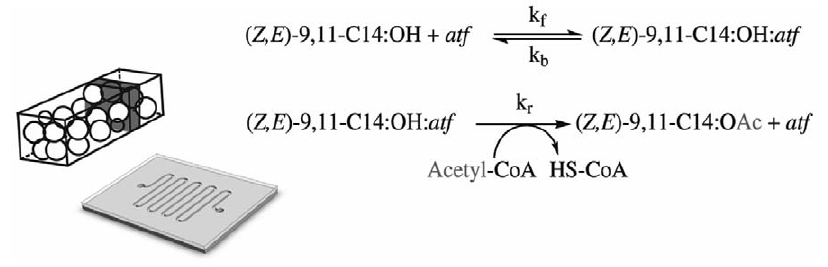
Figure 1. Drawing of the Silicon-glass microreactor with a section of the microchannel packed with NTA-functionalized agarose beads, with the dark grey box representing an infinitesimal volume n , together with the canonical enzymatic reaction, based on the Michaelis and Menten kinetics, adapted for substrate conversion with atf .